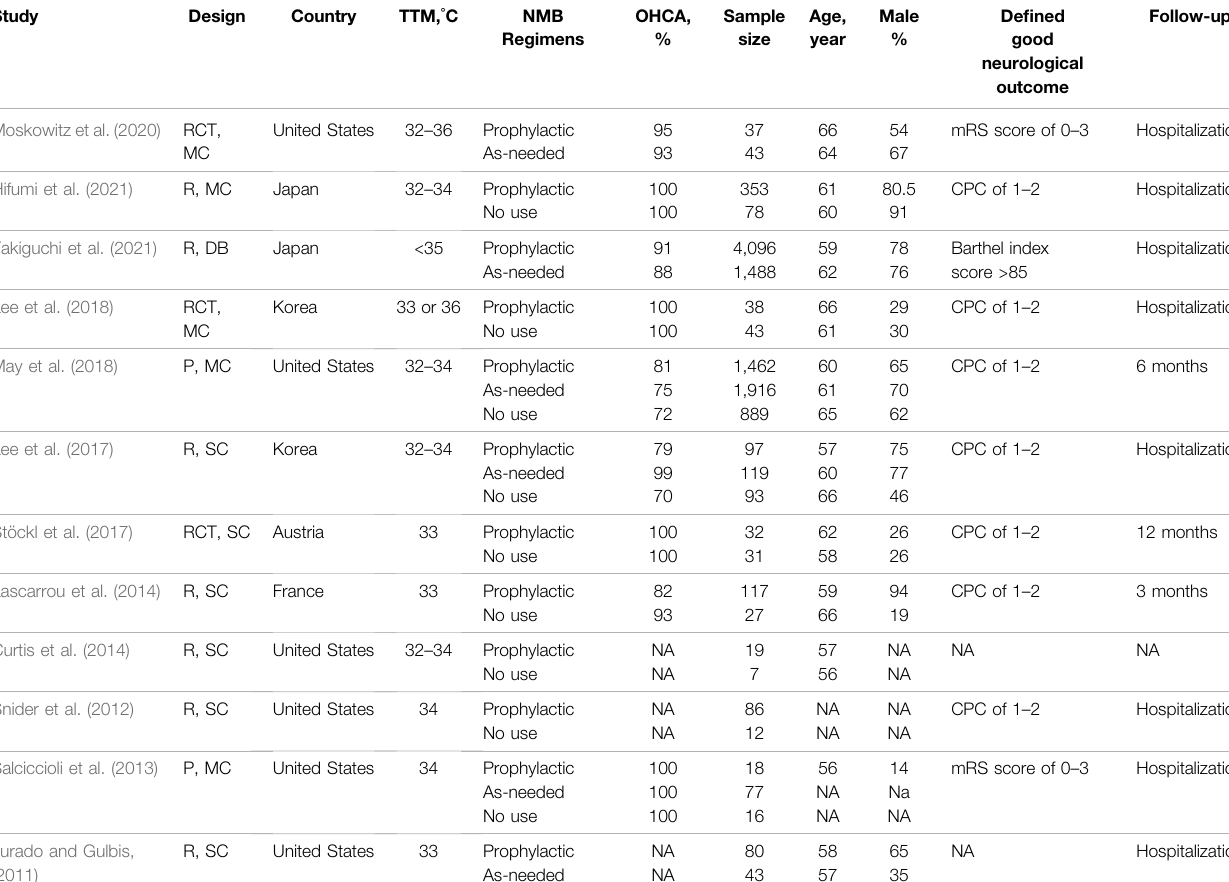
TABLE 1 | Characteristics of the studies included in current systemic review and meta-analysis.